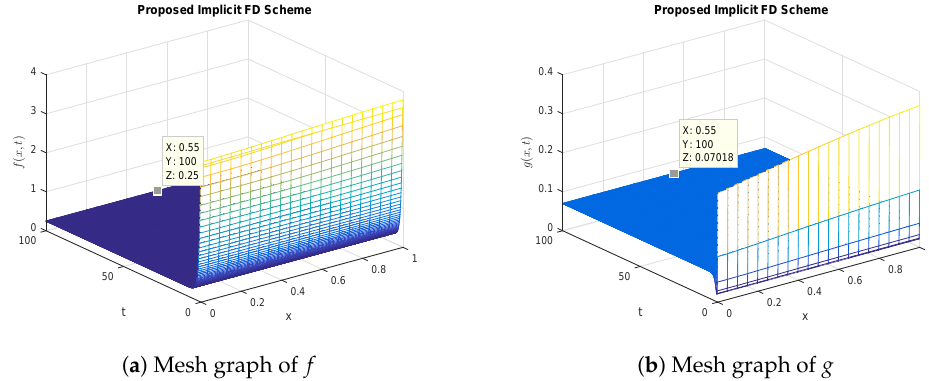
Figure 5. Graphical solution of f , g (concentration of substances) using designed NSFD implicit method at a = 3.5, b = 0.25, χ 1 = 2, χ 2 = χ ∗